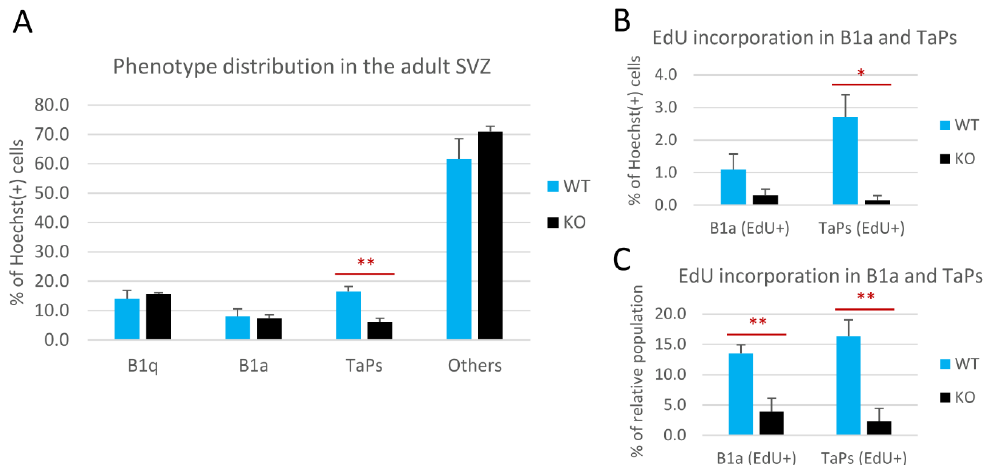
Figure 4. Cyclin D2 deficiency affects transition from B1 active precursors to transit-amplifying progenitors (TaPs) in the adult subventricular zone (SVZ). ( A ) Phenotypic distributions of cells, and ( B , C ) proliferating activity of the B1a and TaPs in the SVZs in cD2-KO and WT mice. Cyclin D2 deficiency impacts ( A ) [graph—all B1a and all TaPs, both EdU( − ) and EdU(+)] the transition from B1a to TaPs, and ( B , C ) [graphs—B1a and TaPs EdU(+) only] reduces the number of actively proliferating B1a and TaPs. The % of the relative population describes the percentage within specific cell subpopulations (B1a or TaPs). EdU—(5-ethynyl-2′-deoxyuridine) labelling of newly generated cells. Data are shown as mean ± SD (* p ≤ 0.05, ** p ≤ 0.01).